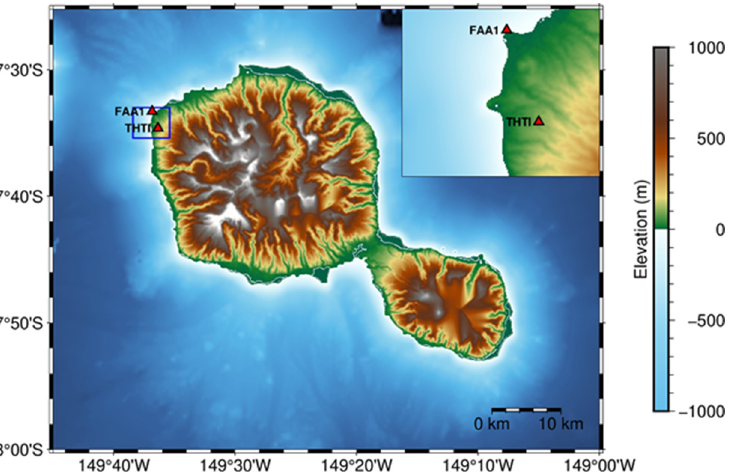
Figure 1. Location of the THTI site (149.61°W, 17.58°S, ellipsoidal altitude 98.49 m) and FAA1 site (149.62°W, 17.56°S, ellipsoidal altitude 12.35 m) on Tahiti Island.